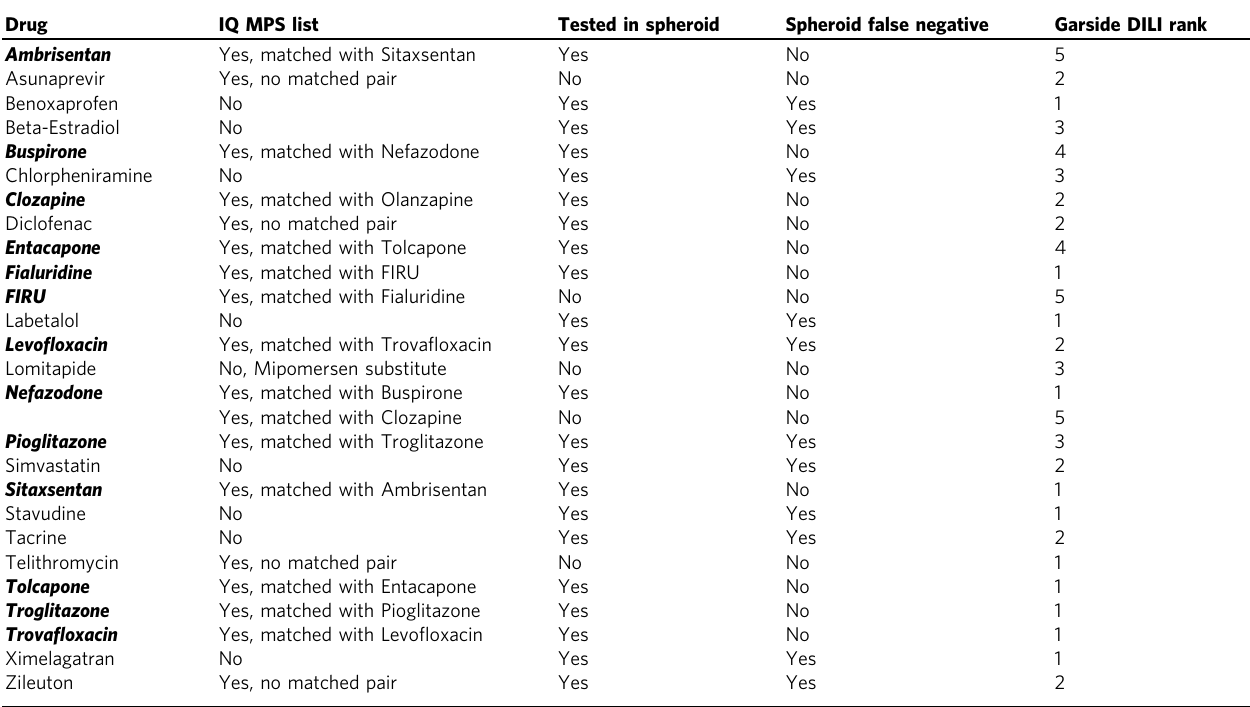
Table 1 Small-molecule drugs used in the Liver-Chip